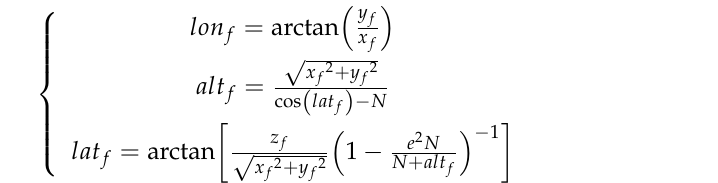
Table 2. Model evaluations on our fire dataset. Model